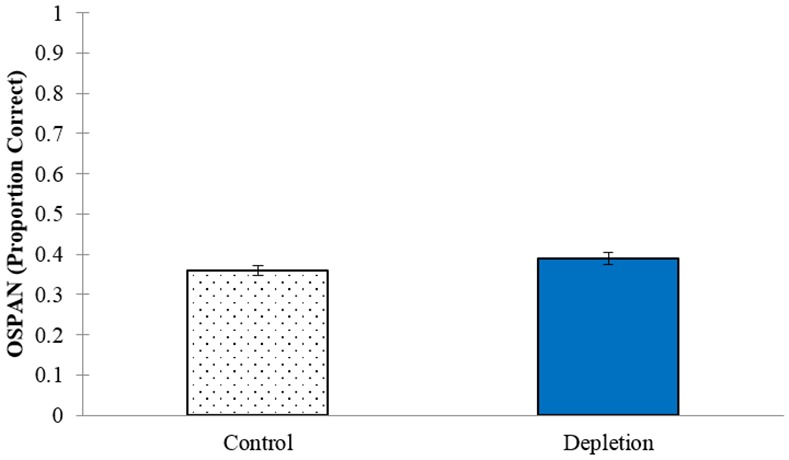
OSPAN performance between conditions.Error bars represent standard error of the mean (SEM).